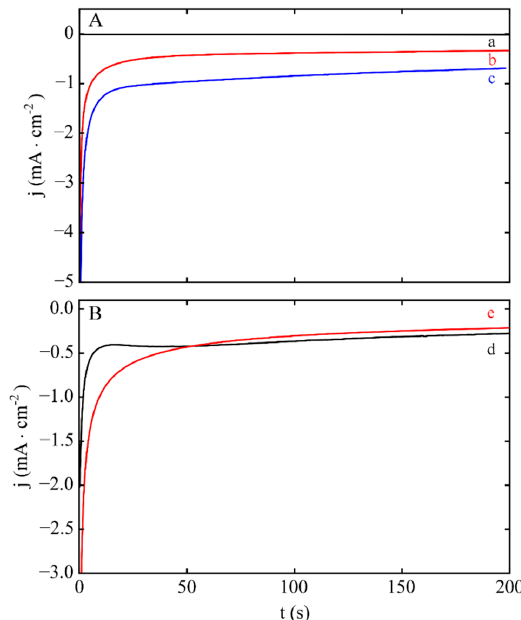
Figure 9. ( A ) Current obtained for the electrodeposition of Pt at E = − 0.5 V vs. Ag/AgCl. a: HOPG in blank solution of 0.5 M NaCl, pH 2.3, b: sample deposited with Pt in blank solution, c: Pt deposition in 3 mM H 2 PtCl 6 , 0.5 M NaCl, pH 2.3. ( B ) Pt deposition current (line d) obtained by subtracting lines